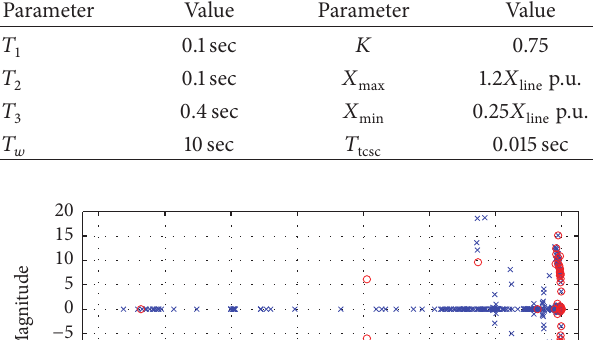
Table 1: The existing compensation ratio on the 500 kV system. Table 2: Parameters of the TCSC controller.